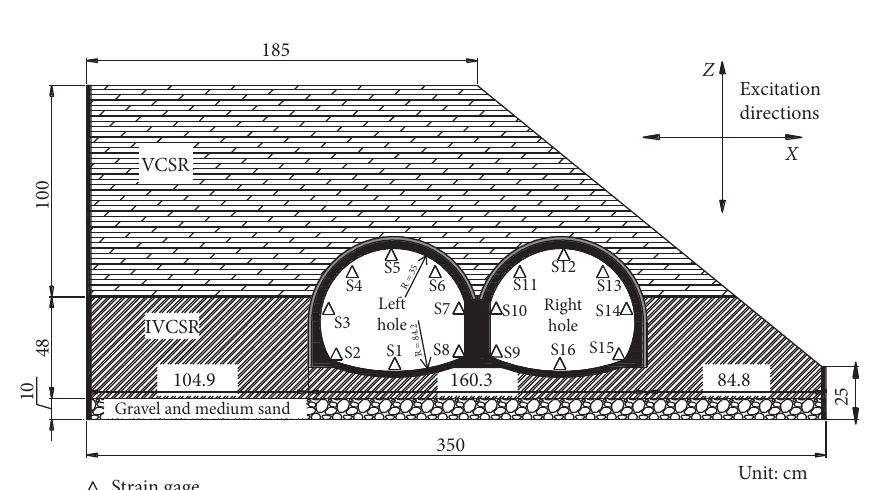
Figure 5: Layout scheme of the accelerometer.